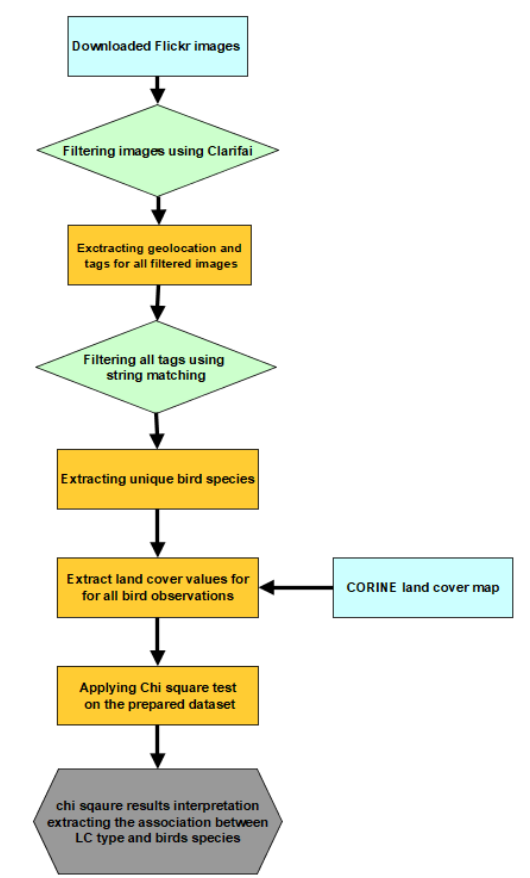
Figure 4: The methodology